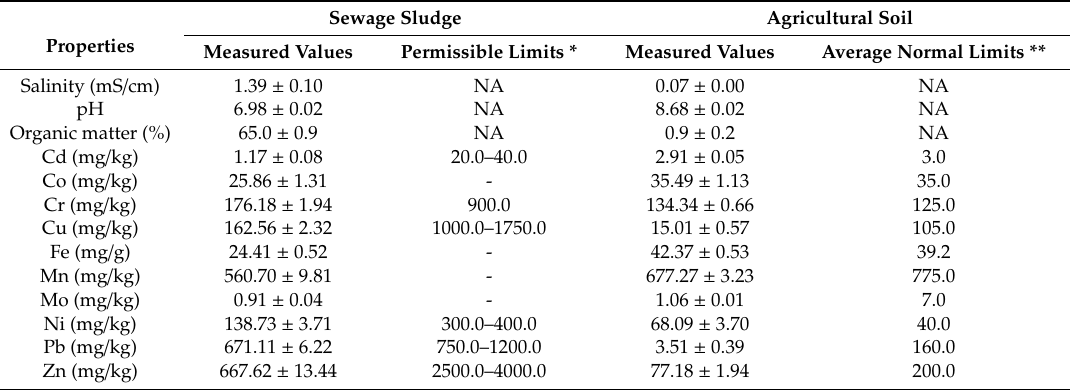
Table 1. Selected chemical properties of sewage sludge and agricultural soil used in the pot experiment (means ± standard error, n = 3).